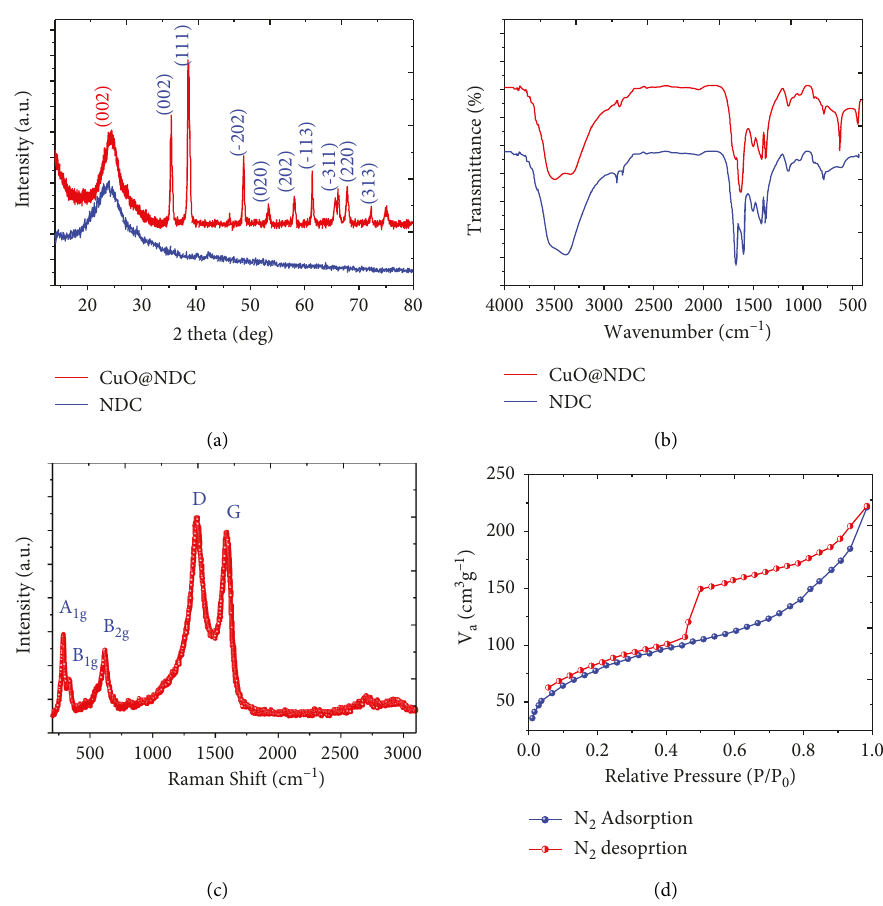
Figure 1: (a). XRD of NDC and CuO@NDC, (b) FTIR spectra of NDC and CuO@NDC, (c) Raman spectra of NDC and CuO@NDC, and (d) N 2 adsorption and desorption isotherm of NDC and